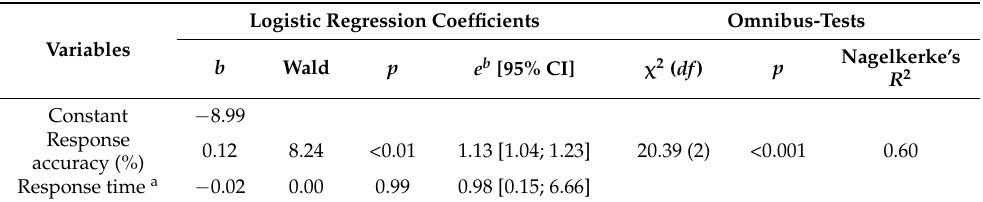
Table 2. Results of the logistic regression analysis for the determination of the elite performance level according to the diagnostic results.